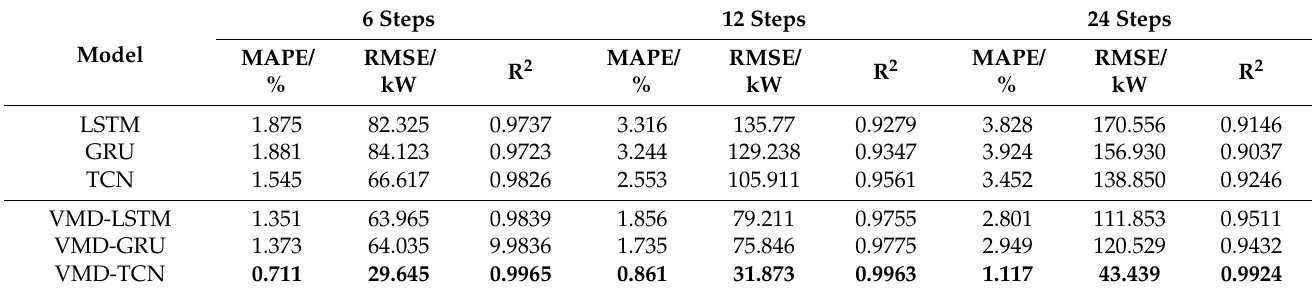
Table 3. Performance evaluations of contrast models for the GEFCom